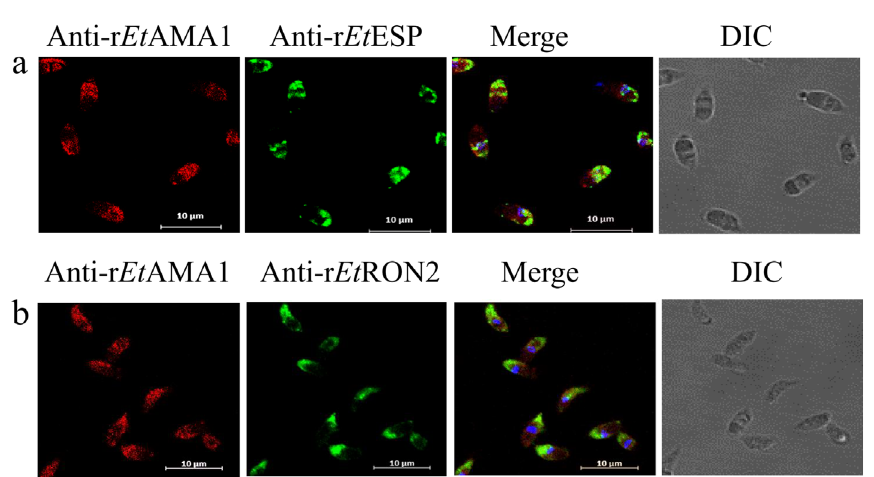
Figure 2. Colocalization of EtAMA1, EtESP, and EtRON2 in sporozoites by indirect immuno fl uorescence. Parasites were immunostained with anti-rEtAMA1, and anti-rEtESP or anti-rEtRON2 antibodies, visualized with FITC (green) and counter-stained with DAPI (blue). Scale bar, 10 l m.